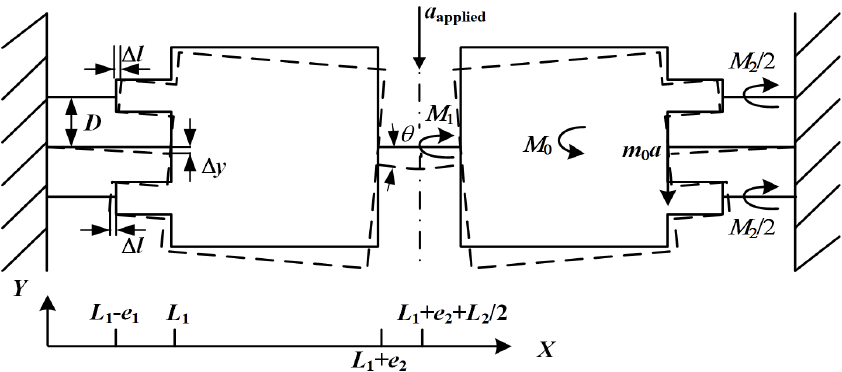
Figure 3. Simplified structure of the proposed structure.